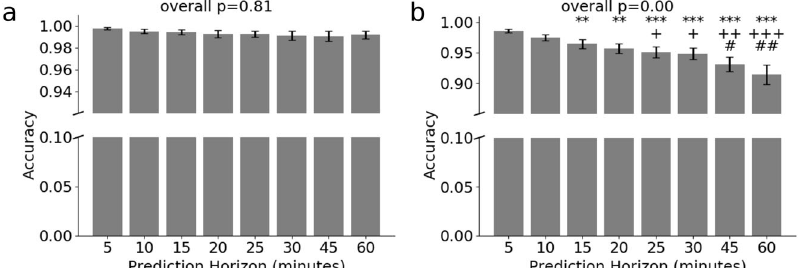
Fig. 3 Prediction accuracy for two classi fi cation tasks given different prediction horizons using the best CNN model. Prediction accuracy for a binary classi fi cation, i.e., identifying the neural network output as hypoglycemia or no hypoglycemia, and b three-class classi fi cation, i.e., identifying the neural network output as hypoglycemia or normoglycemia or hypoglycemia, given different prediction horizons. No statistical signi fi cance is observed for binary classi fi cation. * p -value ≤ 0.05; ** p -value ≤ 0.01; *** p -value ≤ 0.001, in comparison to the prediction horizon at 5 min; + p -value ≤ 0.05; ++ p -value ≤ 0.01; +++ p -value ≤ 0.001, in comparison to the prediction horizon at 10 min and # p -value ≤ 0.05; ##p -value ≤ 0.01; ### p -value ≤ 0.001, in comparison to the prediction horizon at 15 min. Error bars (standard deviation, s.d.) are computed over all patients ’